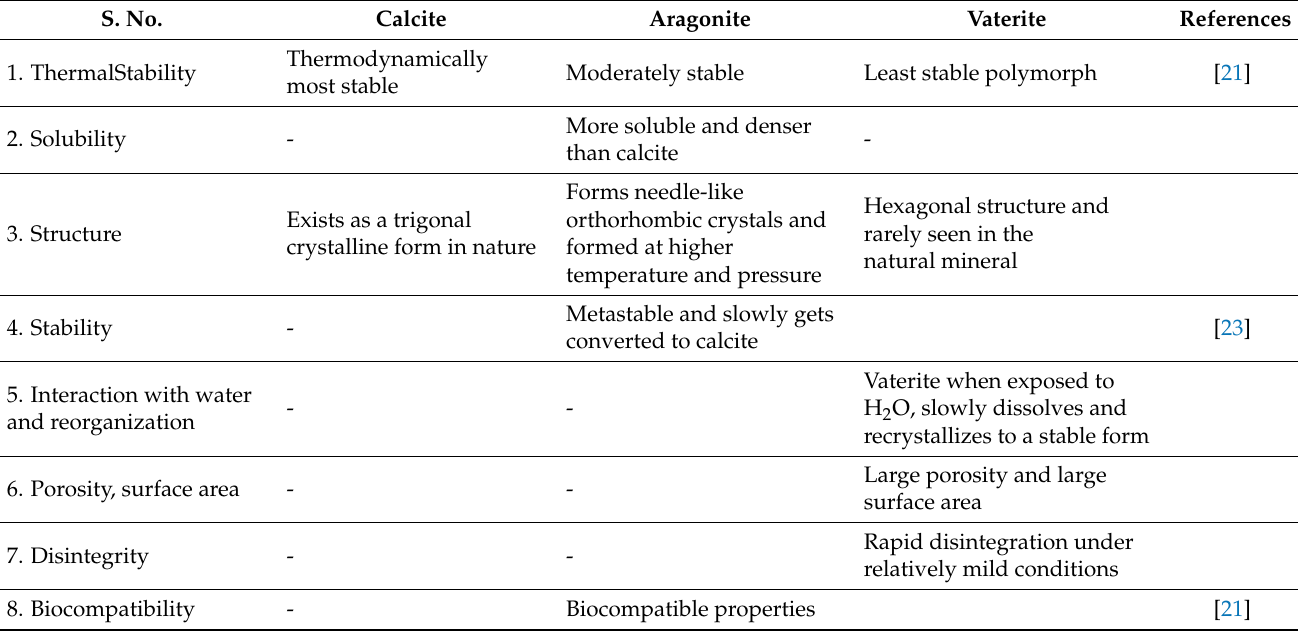
Table 2. Differences between different types of calcium carbonate nanoparticles polymorphs. S.